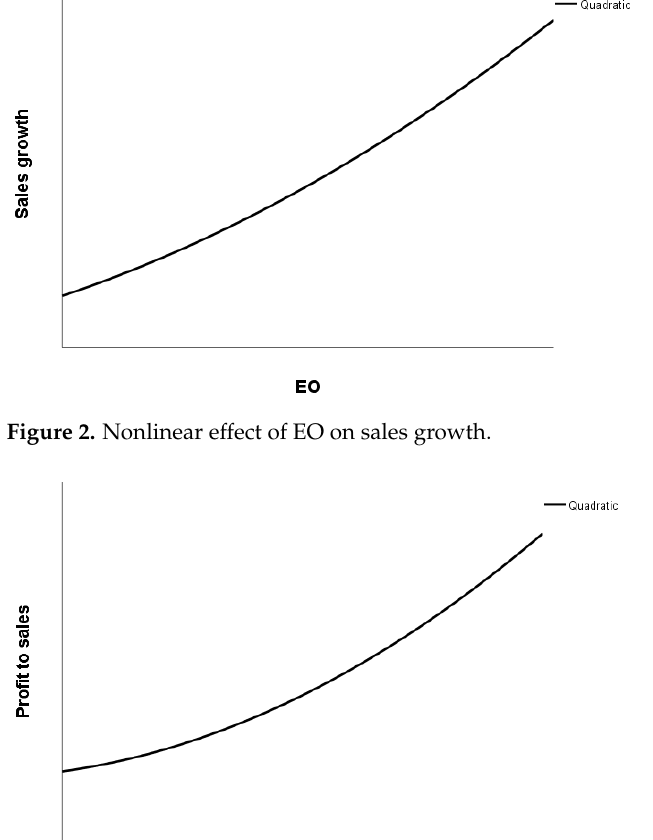
Figure 2. Nonlinear effect of EO on sales growth.